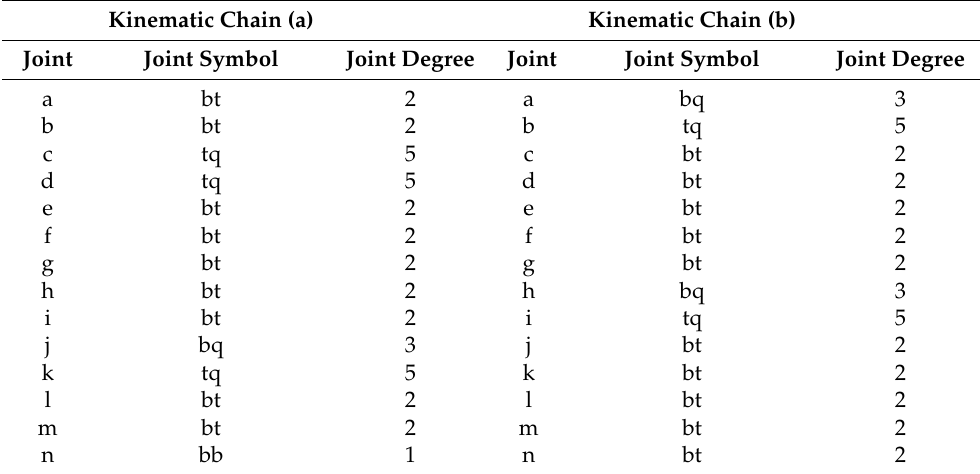
Table 3. Values of Joint degrees for kinematic chains in Figure